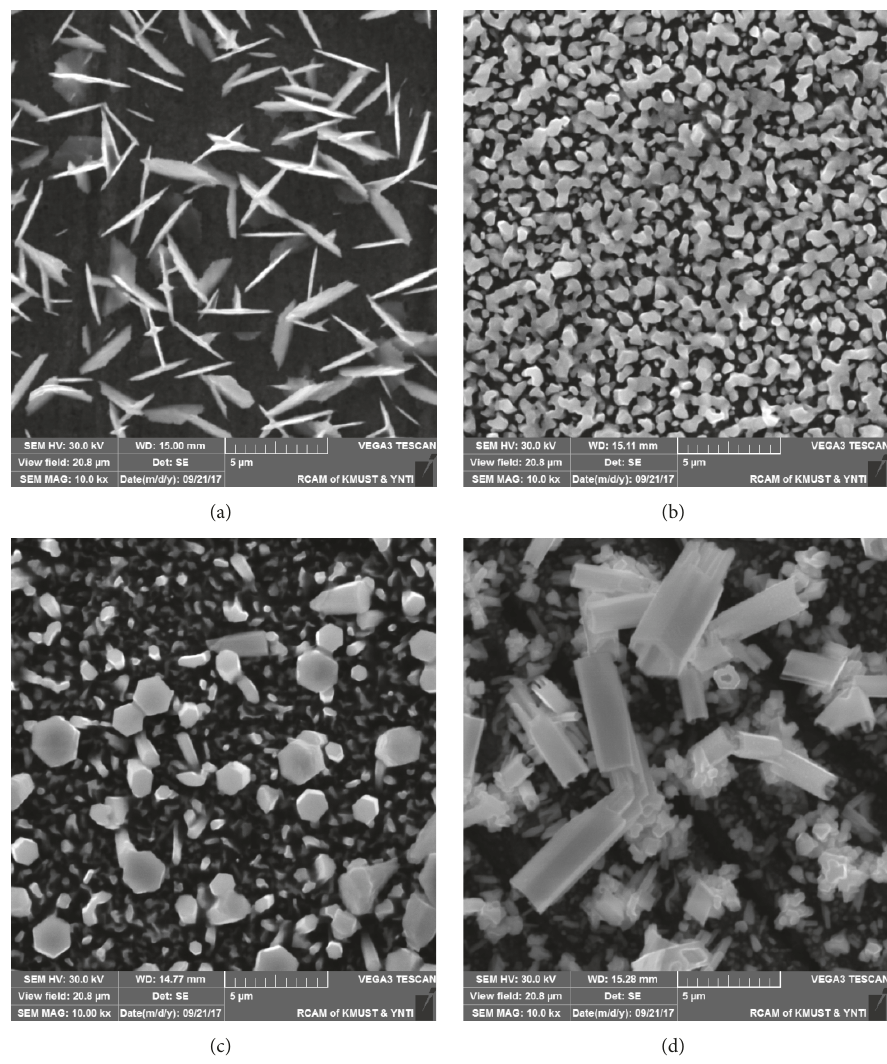
Figure 4: SEM images of Sn deposits obtained from the [Bmim]HSO 4 /H 2 O mixture (30% H 2 O, v/v) solution containing 40mM SnO at different deposition potential: (a) -0.45 V, (b) -0.5 V, (c) -0.55 V, and (d) -0.6 V. Temperature: